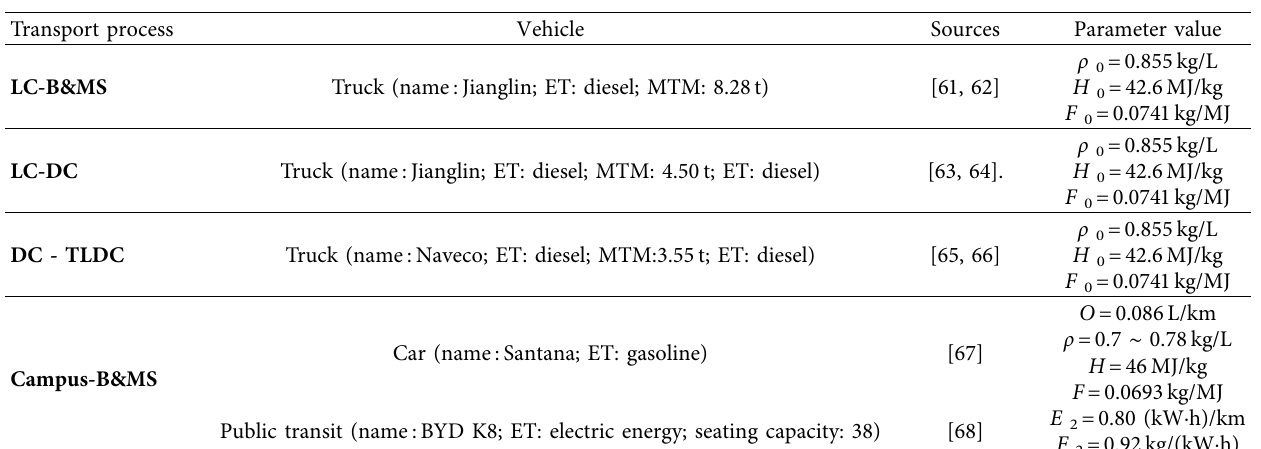
Table 7: Vehicles’ specifications.